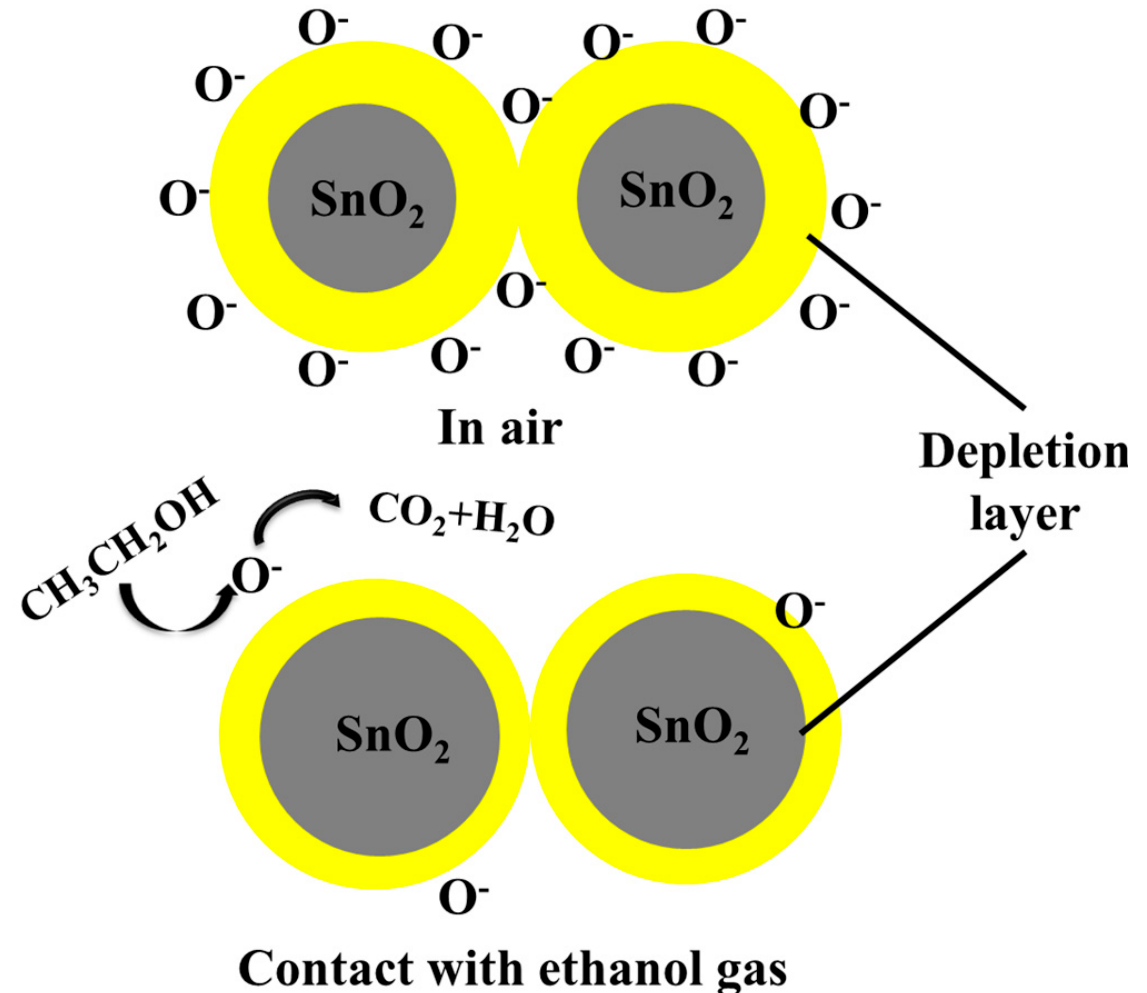
Figure 9. Schematic diagram of surface resistance control model of SnO 2